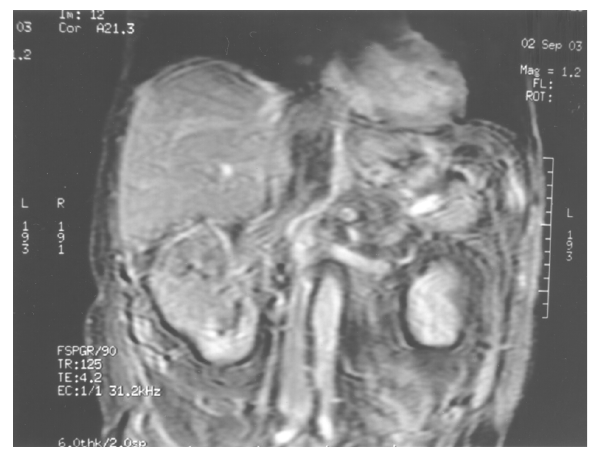
Figure 1 – Magnetic resonance imaging demonstrating right kidney tumor and level-III (atrial) thrombus in the inferior vena